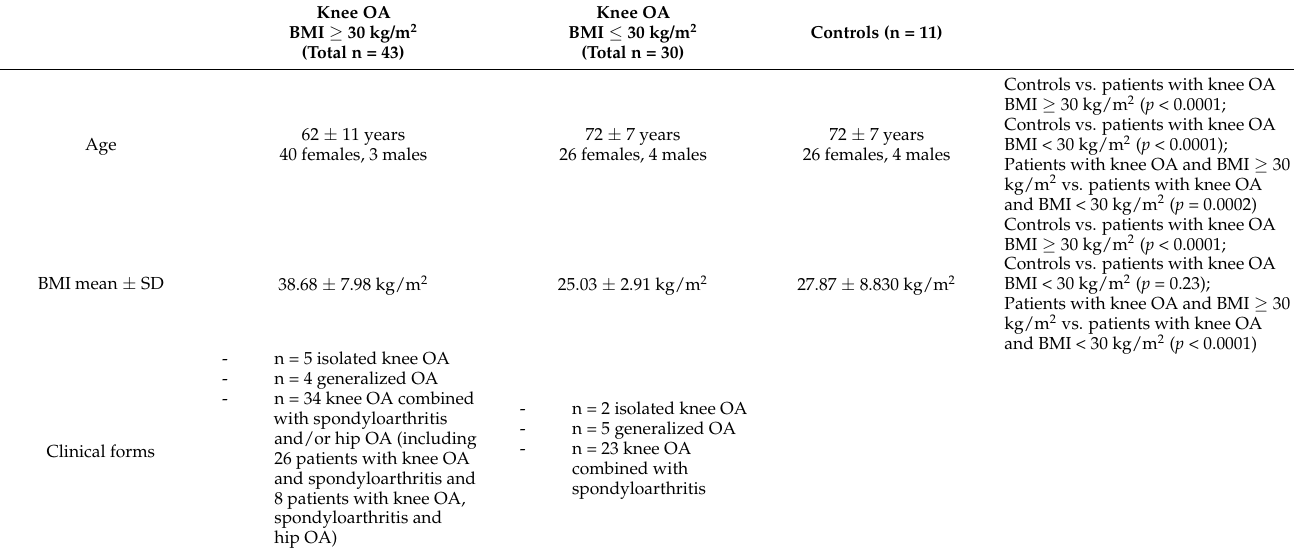
Table 1. Clinical and demographic characteristics of the patients with knee OA.